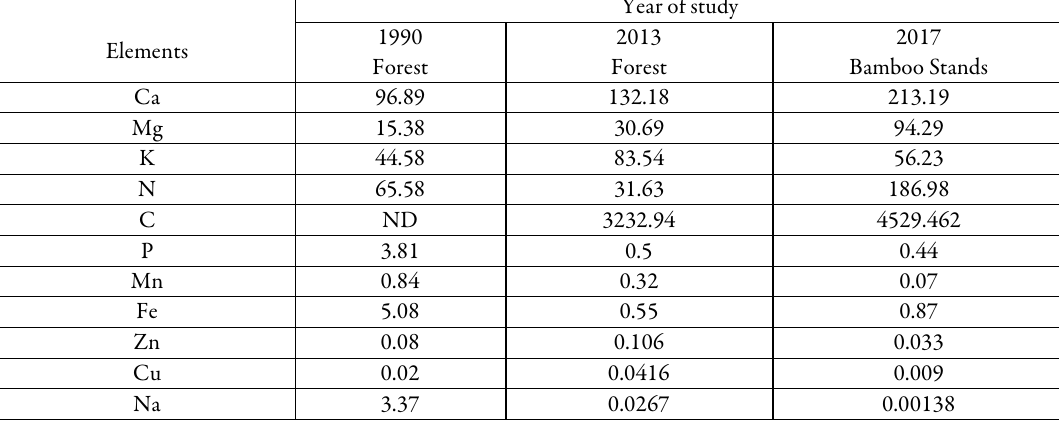
Table 2. Comparison of Nutrients Deposition (Kg ha -1 yr -1 ) in the bamboo stands with other area in